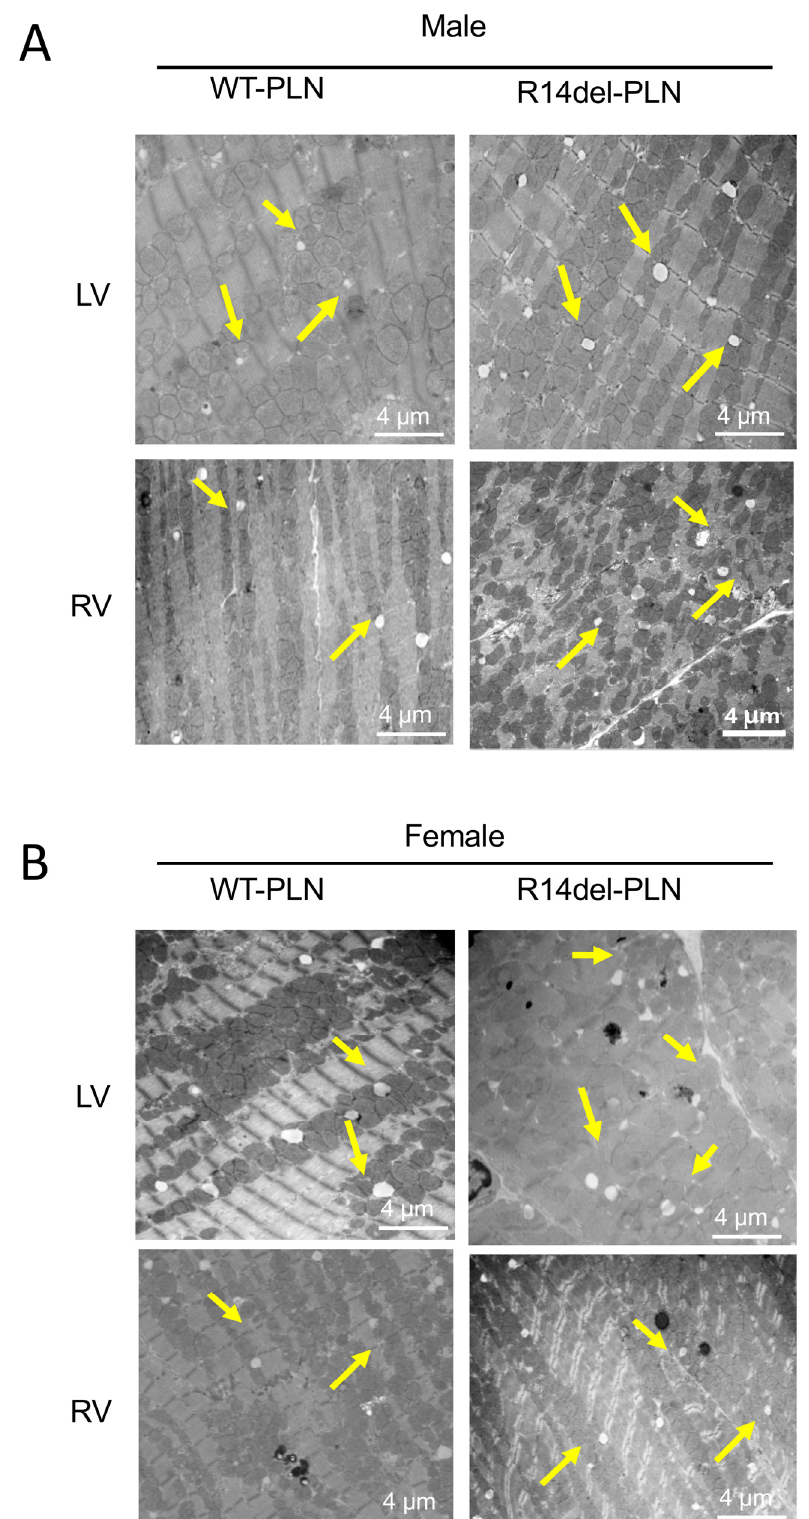
Figure 9. Transmission electron microscopy (TEM) evaluations of left ventricle (LV top panels) and right ventricle (RV bottom panels) from 12-month-old male ( A ) and female ( B ) WT- PLN and R14del- PLN mice. Ultrastructural images from longitudinal sections of LV and RV showed lipid droplets (yellow arrows), with a higher number in R14del- PLN ventricles. N = 4 per group. Scale bar: 4 µm, magnification 15,000×.